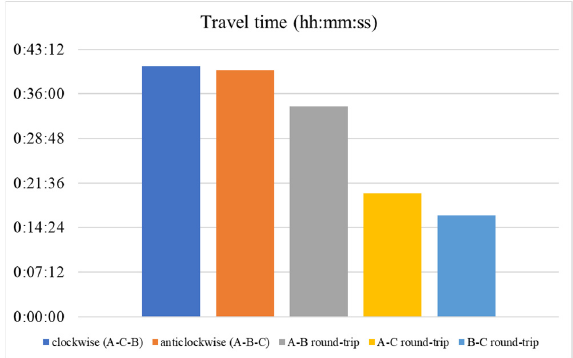
Figure 12. Travel time comparison of the multi-point routes.